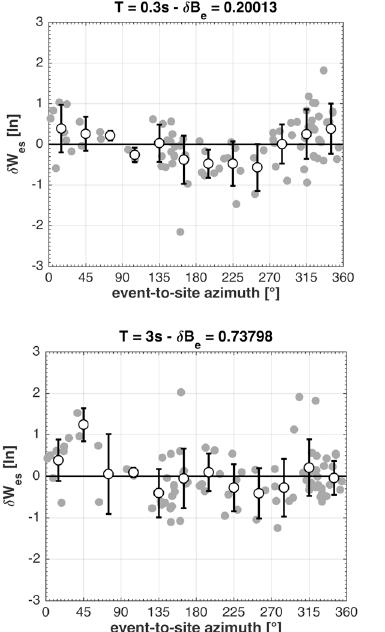
Figure 8 . Within-event residuals δ Wes vs. azi- muth for SA at T=0.3s (top) and 3s (bottom) for the stations within R JB =80km. The event-to-site azimuth is computed clockwise from the north. The between-event value is reported in the title.